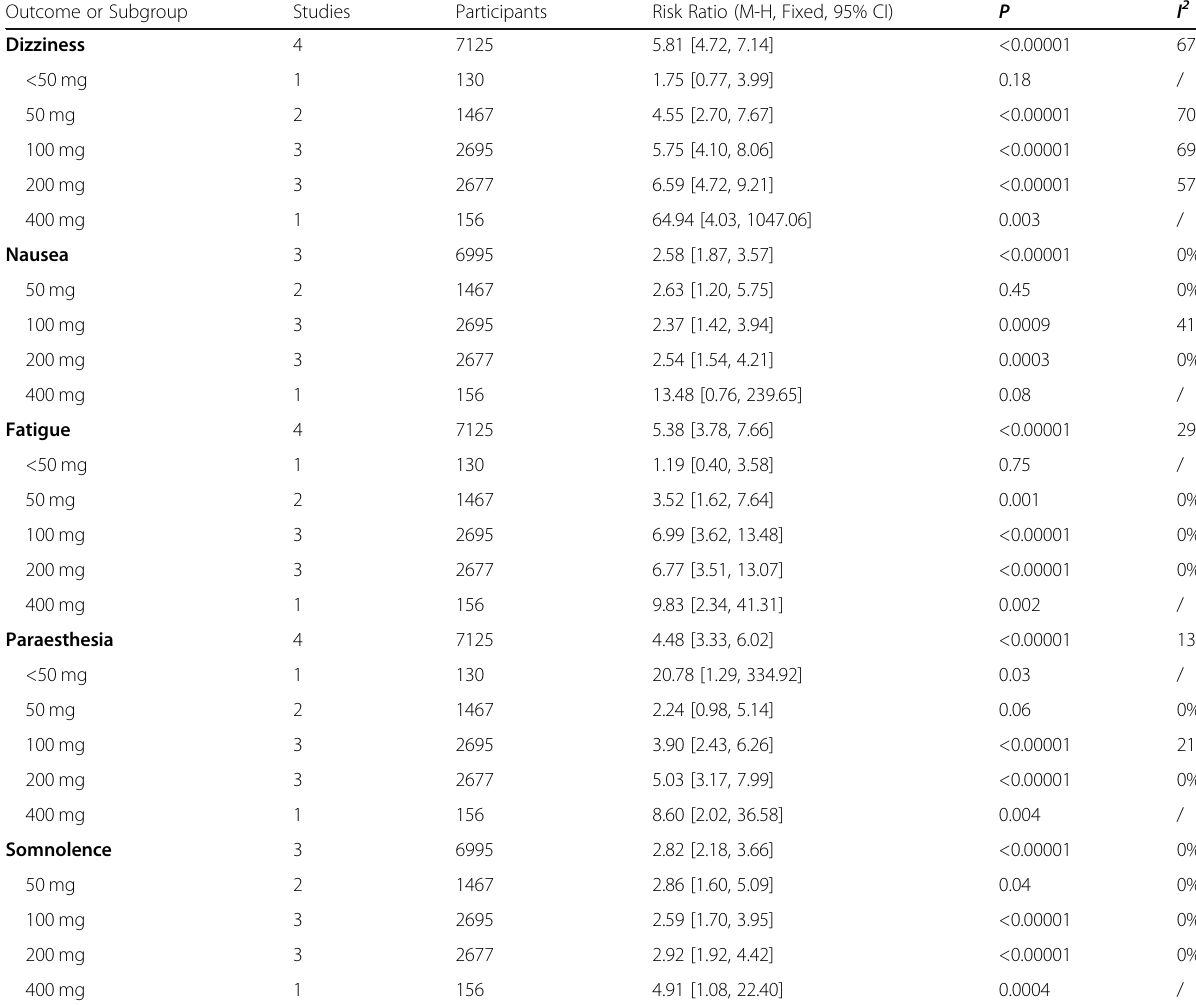
Table 2 Comparison of main TEAEs between different doses of lasmiditan and placebo Outcome or Subgroup